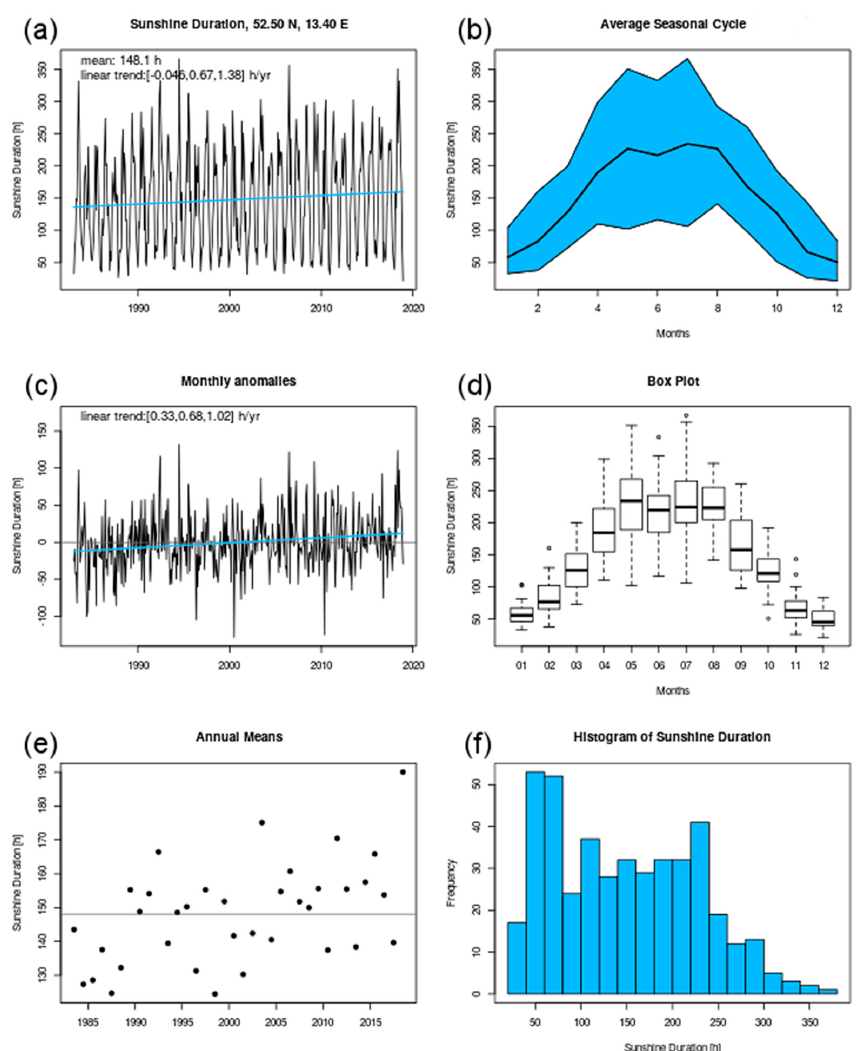
◦ N; 13.4 ◦ E) from 1983 to 2018. Shown